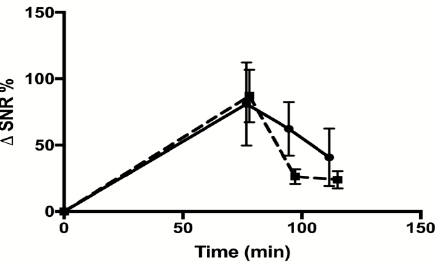
Figure 6. Measurement of renal clearance of Gd-DOTA-P88 and Gd-DOTA-Scramble. Mice were implanted with CHO-FXYD2 γ a + in the right hind leg and wildtype CHO cells in the left hind leg. MRI images were taken after 0, 75, 95, and 115 min. The signals emitted by the kidneys were quantified within regions-of-interest (ROIs) drawn around each kidney. The contrast enhancement is expressed as Δ SNR%. The solid line indicates the values obtained for Gd-DOTA-P88 and the dashed line indicates those of Gd-DOTA-Scramble. The data are expressed as means ± SD, n = 3–4 mice in each group.